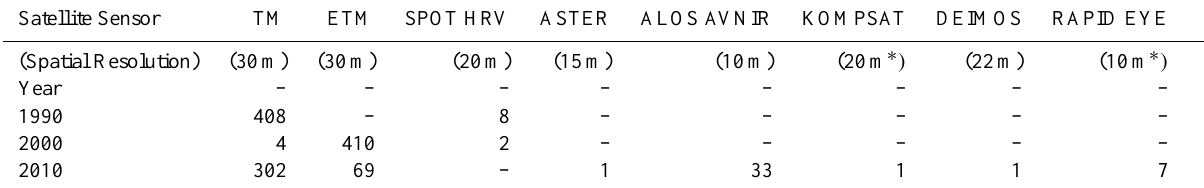
Table 1. Use of satellite imagery for sample sites in Southeast Asia.